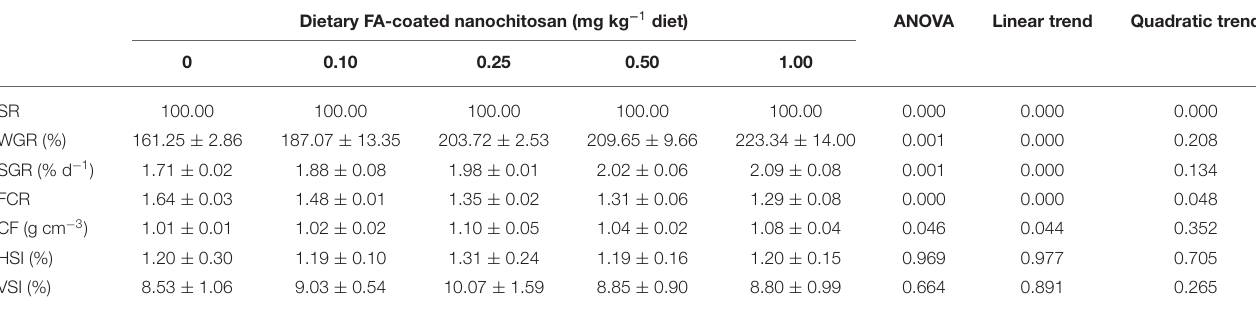
TABLE 2 | Growth performance and feed utilization of fingerling rainbow trout, Oncorhynchus mykiss , fed diets containing varying levels of folic acid-coated nanochitosan*. Dietary FA-coated nanochitosan (mg kg − 1 diet) ANOVA Linear trend Quadratic trend